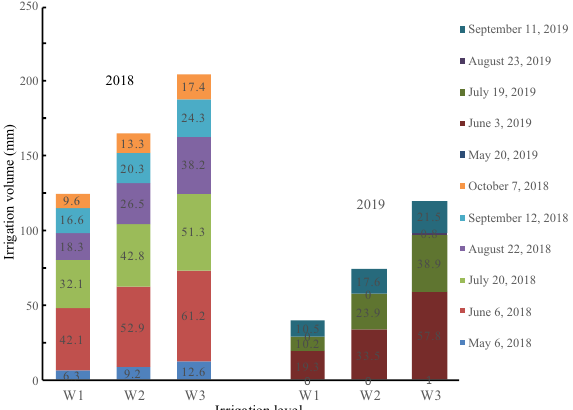
Figure 2. Irrigation schedule in 2018 and 2019.